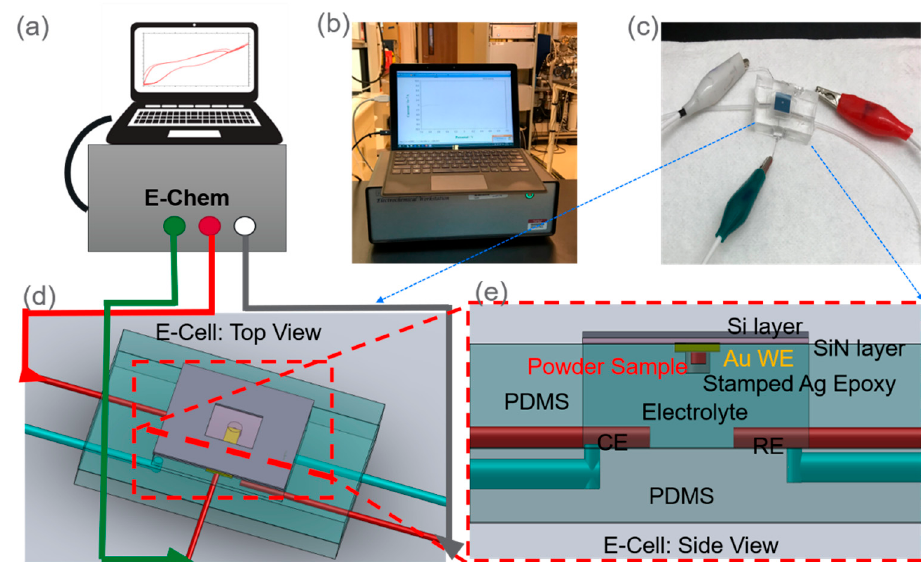
Figure 2. The overview of the electrochemical analysis setup: ( a ) the electrochemical station with the control computer green port (WE), red port (CE), and white port (RE); ( b ) a picture of the electrochemical station; ( c ) a close-up picture of the SALVI E-cell connected with alligator clips to the electrochemical station; ( d ) a 3D rendering image of the top view of the SALVI E-cell; and ( e ) a cross-section view of the microfluidic cell.